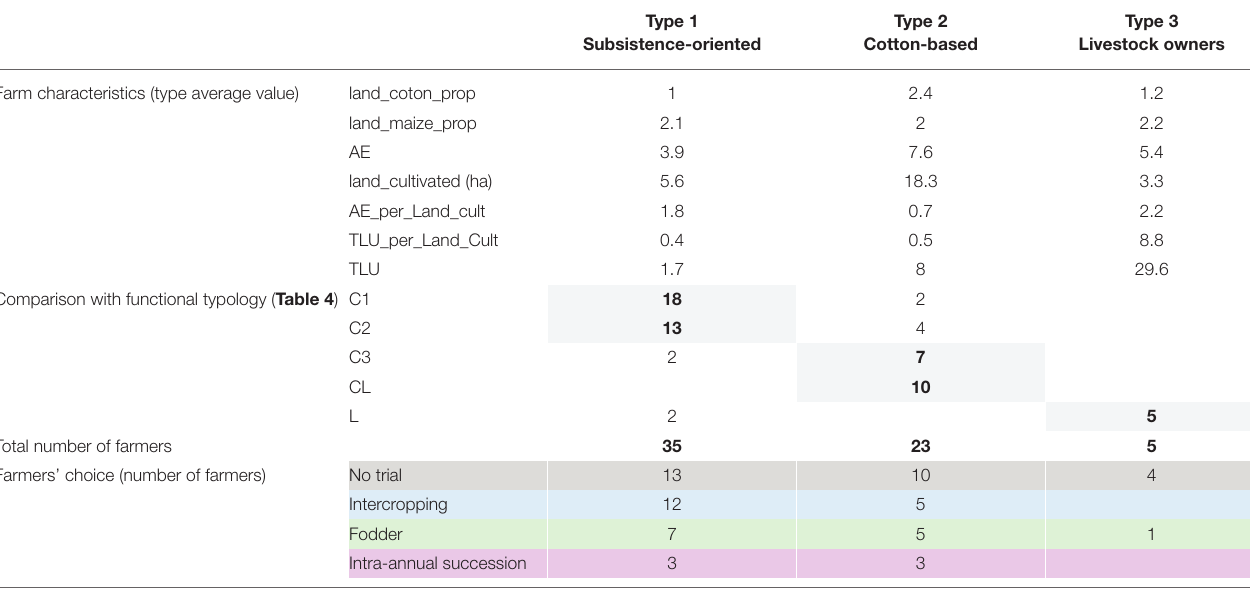
TABLE 5 | Main characteristics of farming system types and type of SCI choices according to the statistical